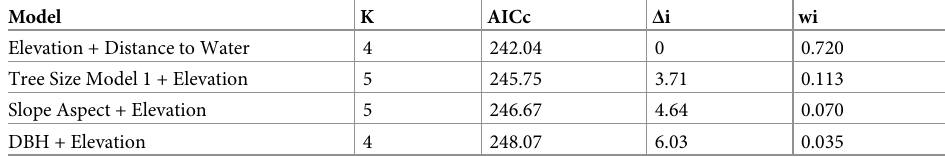
Table 3. Top 4 models for day-roost selection by male and female eastern red bats, along with the number of parameters, AICc score, Δ AICc score, and model weight for each, for Sunday Creek Coal. Model